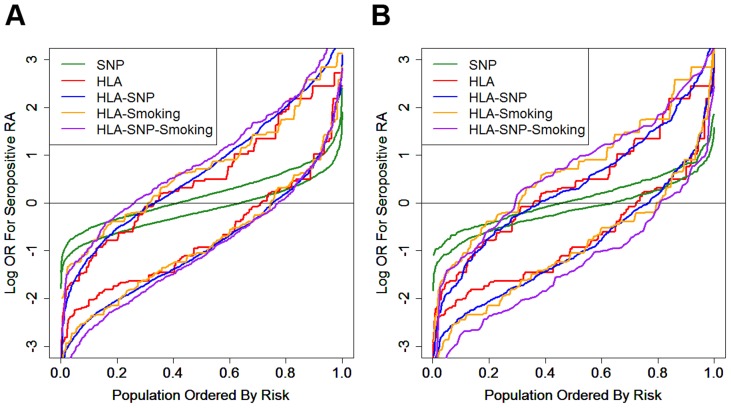
Prediction model generated risk profiles for ACPA-positive RA and controls.Panel A = WTCCC; Panel B = UKRAGG; the upper set of lines for each model refer to RA cases; the lower set of lines refer to controls; OR = odds ratio.